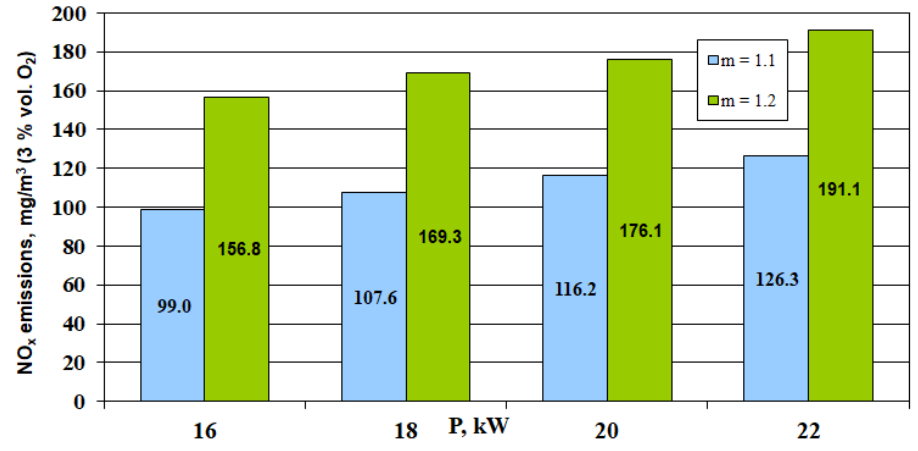
Figure 8. Nitrogen oxide formation (expressed in mg/m 3 at 3% vol. oxygen in dry flue gas under normal temperature and pressure) as a result of variable burner fuel input and air excess coefficient m = 1.1 and 1.2.